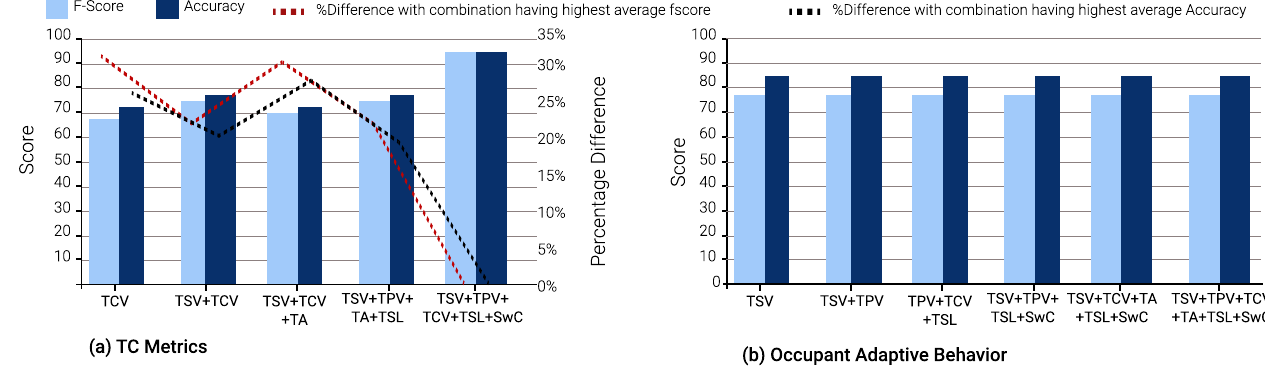
Figure 12. Extreme Gradient Boost Algorithm for Winter